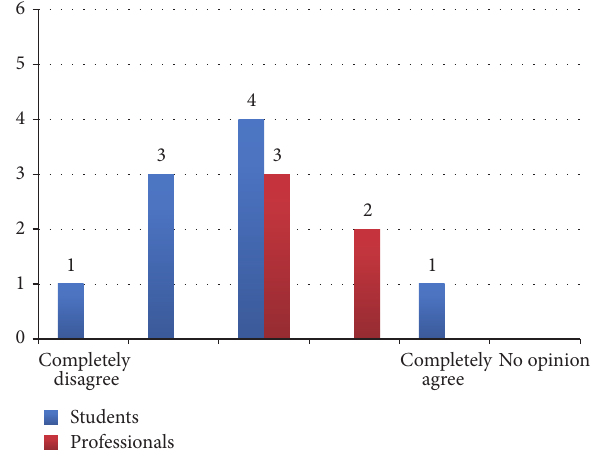
Figure 9: ECW/PUEA result in high quality information in relation to the effort it requires.